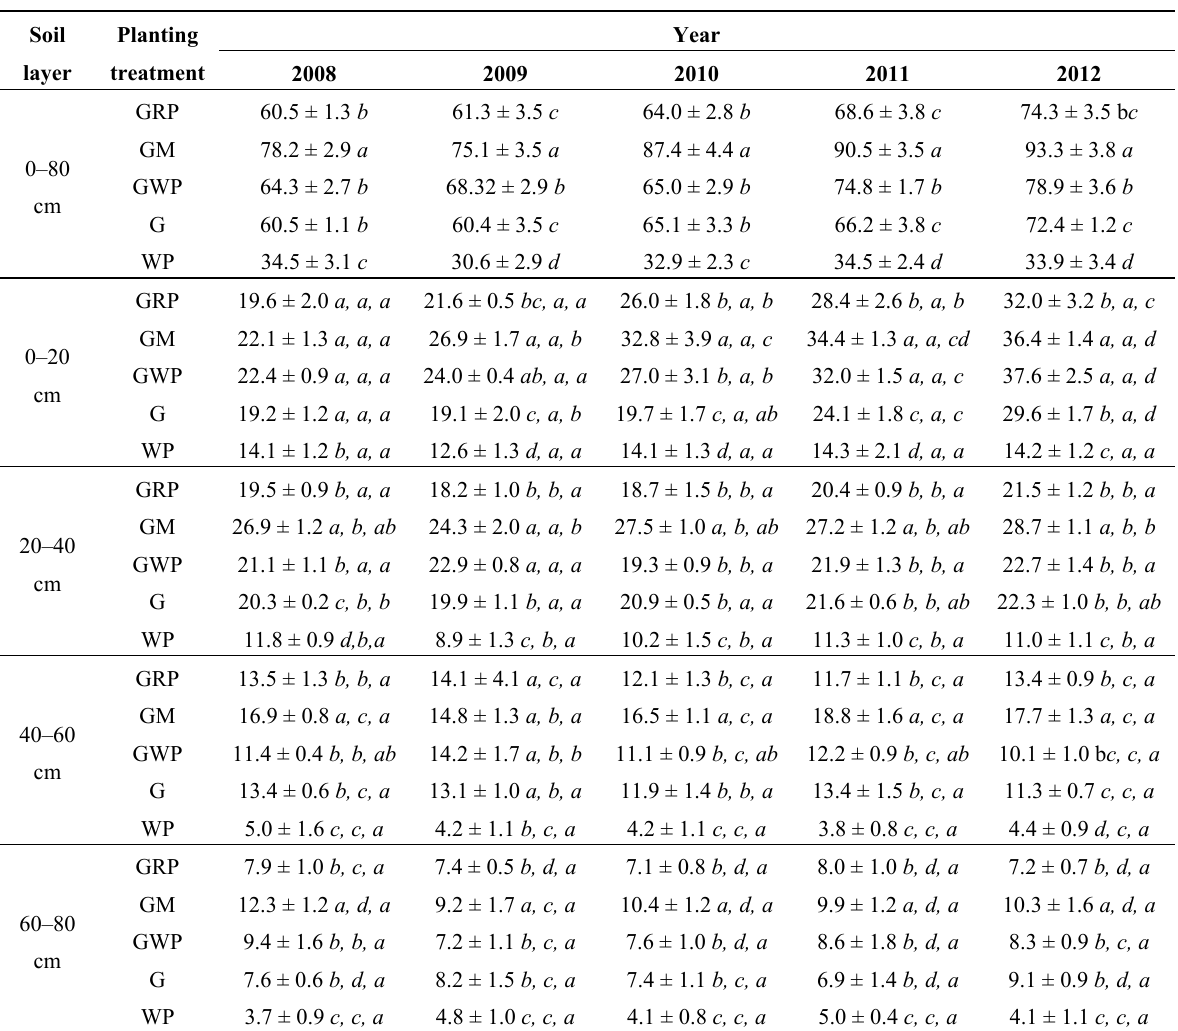
Table 3. Mean (± SD; n = 3) total soil C (t·ha − 1 ) to 80 cm and at 20-cm layers, for five treatments, Ginkgo + rapa + peanut (GRP); Ginkgo + mulberry (GM); Ginkgo + wheat + peanut (GWP); Ginkgo afforestation (G); and wheat + peanut (WP). The first letters are tests across planting treatment for a given year and soil layer. Letters behind the first comma are tests across soil layer within a given year and planting treatment. Letters behind the second comma are tests across years within a given soil layer and planting treatment. Different letters denote statistically significant differences ( p <